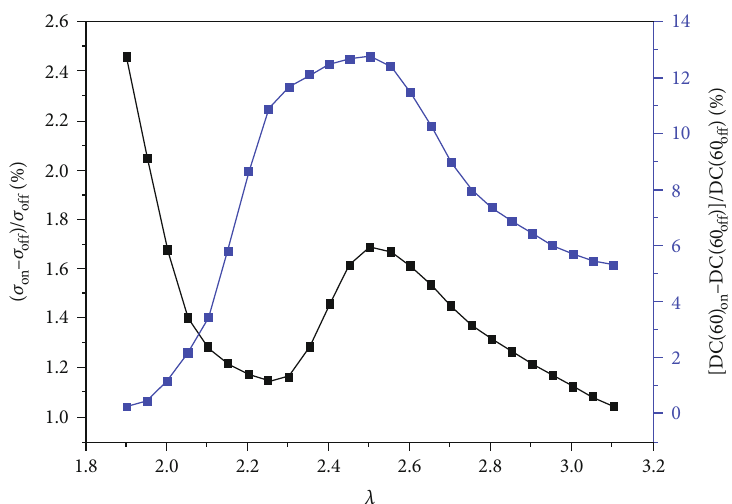
Figure 16: The total pressure recovery coe ffi cient and distortion coe ffi cient on the AIP vary with λ .